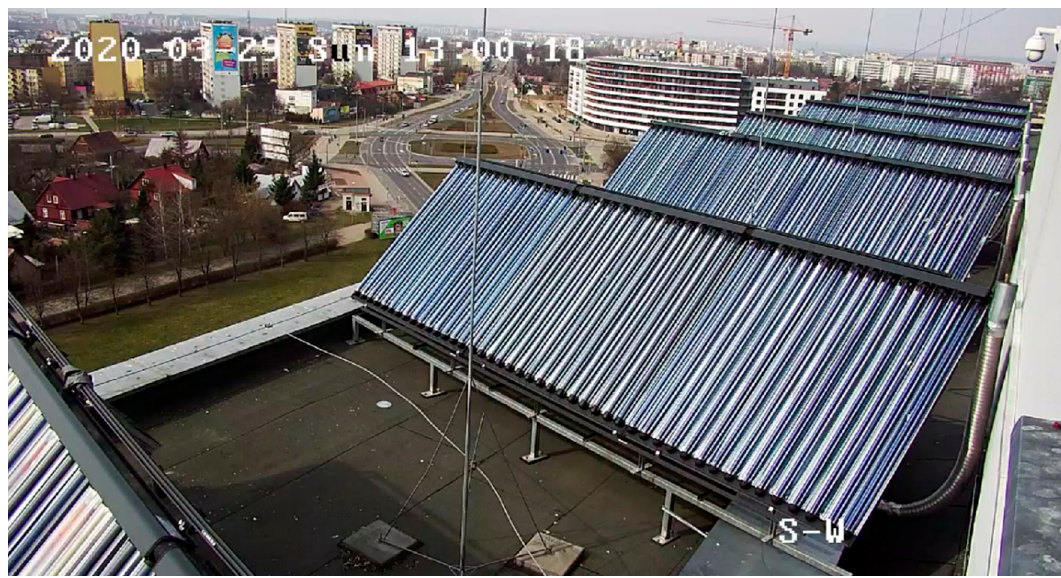
Figure 2. Evacuated tube solar collectors connected in series of three panels grouped into five subarrays. A simplified connection diagram of the system components is shown in Figure 3. The entire installation consists of two identical circuits connected in parallel.